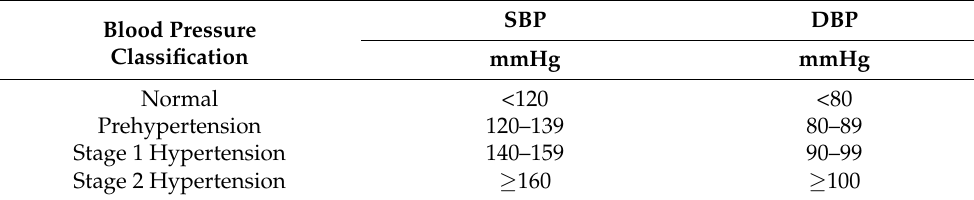
Table 1. Diagnosis of